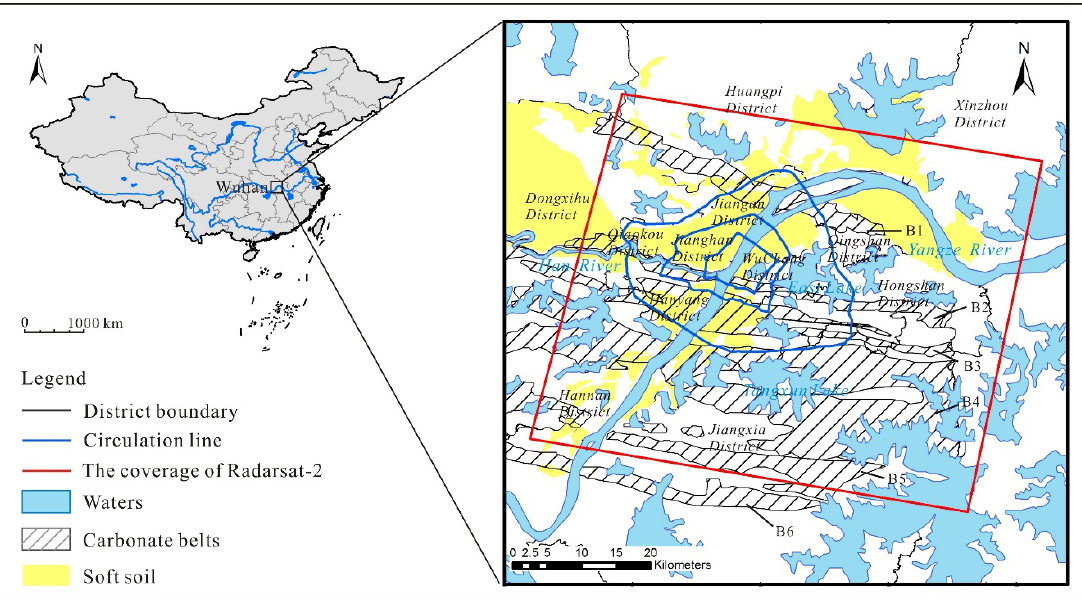
Figure 1. The location of Wuhan city in China and the study area. The red rectangle illustrates the coverage of Radarsat-2. B1–B6 represent six carbonate rock belts aligned in an East-West orientation, namely Tianxingzhou, Daqiao, Baishazhou, Zhuankou, Junshan, and Hannan.